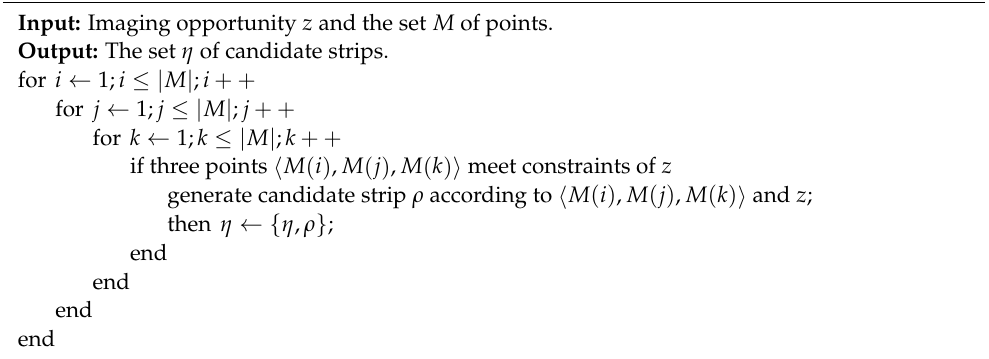
Algorithm 1 Candidate strip generation